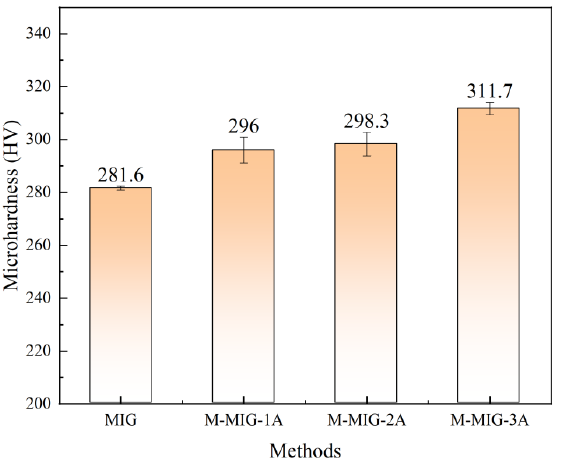
Figure 10. Microhardness of the deposition layer obtained by using wire feeding speed of 4 m/min.